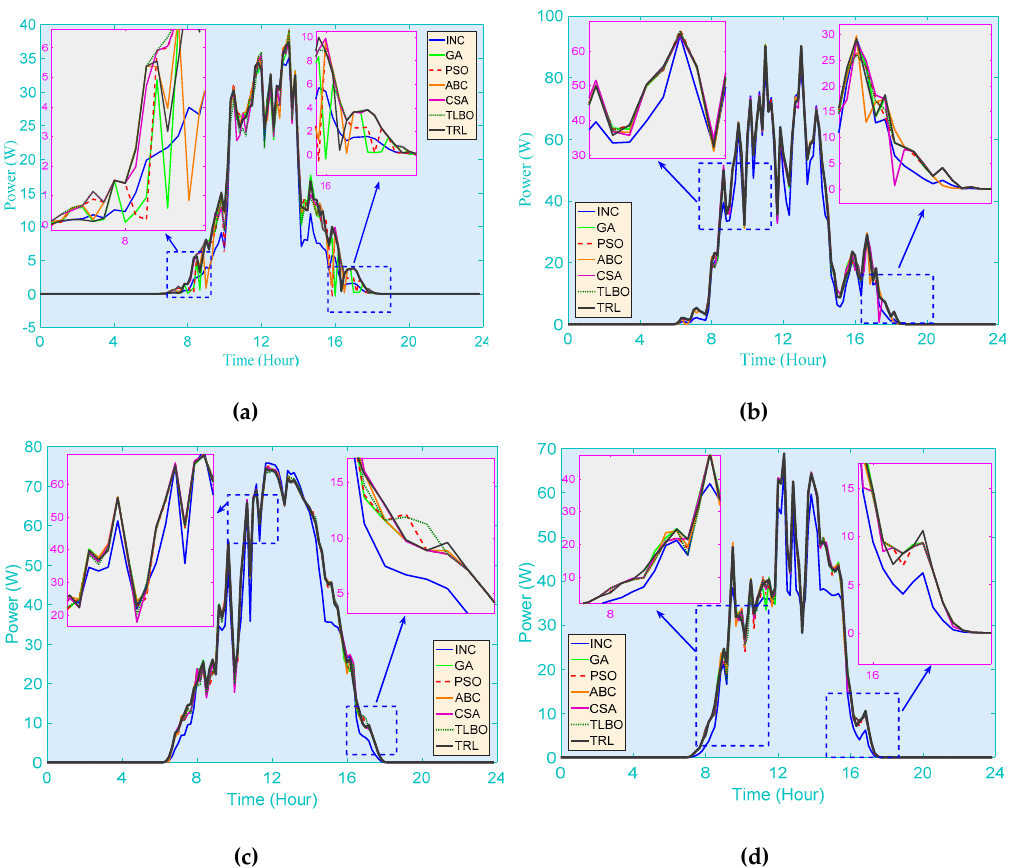
Figure 11. The detailed geographical position of the measuring device for solar irradiation and temperature.